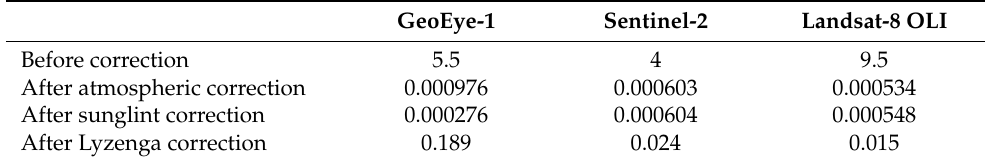
Table 3. Comparison of the corrected images by standard deviation values. GeoEye-1 Sentinel-2 Landsat-8 OLI Before correction 5.5 4 9.5 After atmospheric correction 0.000976 0.000603 0.000534 After sunglint correction 0.000276 0.000604 0.000548 After Lyzenga correction 0.189 0.024